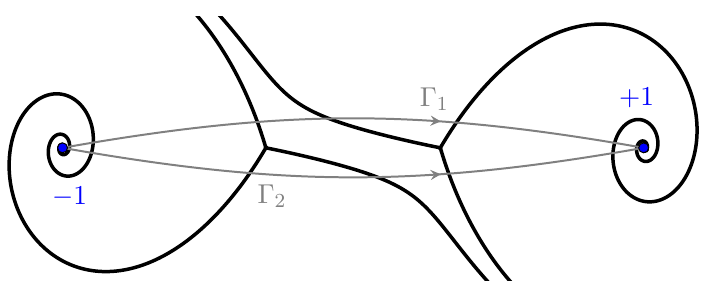
Figure 11 . Spectral networks for a conifold with the following choice of parameters: µ 1 = 1 . 2 × e 0 . 07 π i , µ 2 = 2 . 2 × e 0 . 07 π i , µ 3 = 3 . 248 × e 0 . 07 π i , µ 4 = 2 . 248 × e 0 . 07 π i . The spectral networks is